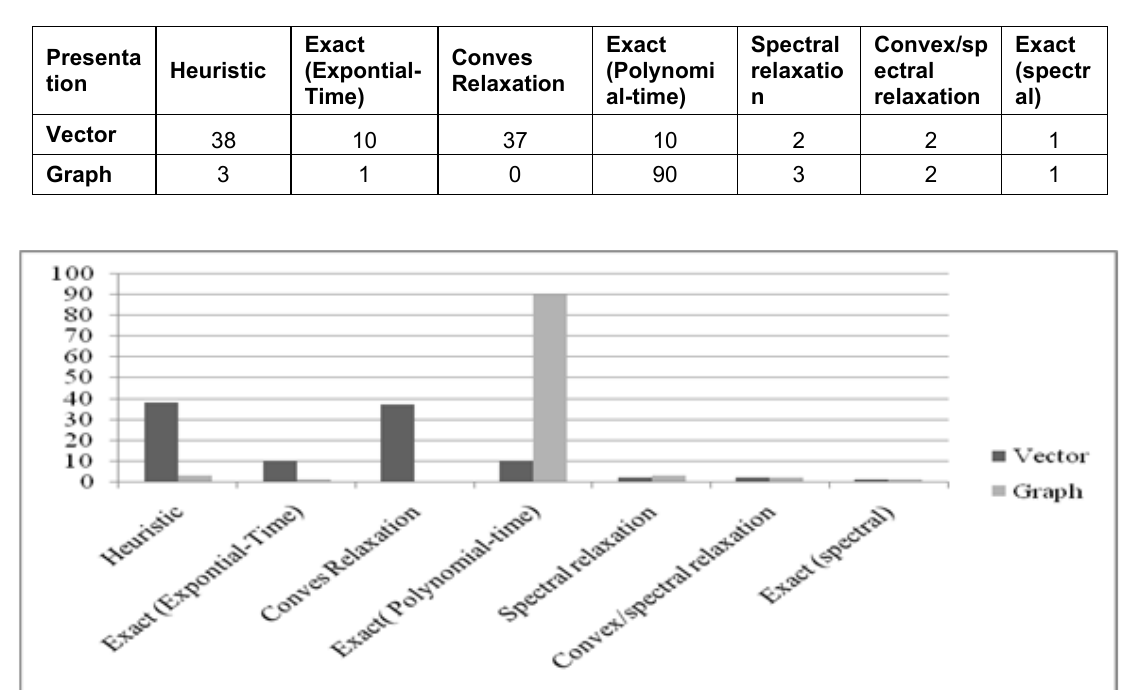
Figure 1. Classification of Machine Learning Approach Table 2. Approach in percentage (%) can be applied for supervised framework according to the presentation of the d.